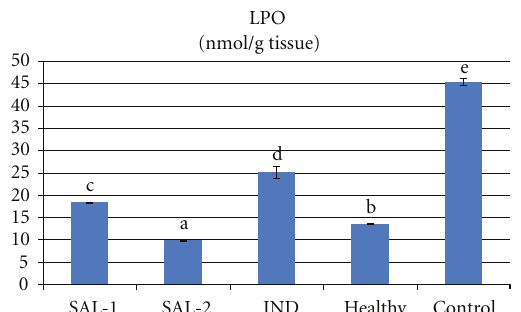
Figure 4: E ff ects of salbutamol (SAL) and indomethacin (IND) on lipid peroxidation (LPO) level in carrageenan-injected paw tissues. Means in the same column by the same letter are not significantly di ff erent and the means in the same column by di ff erent letters demonstrates significant di ff erences between the groups according to the Duncan test ( α = 0 . 05). In the above figure, all columns have di ff erent letters. This demonstrates that values in these columns are statistically di ff erent from each other.